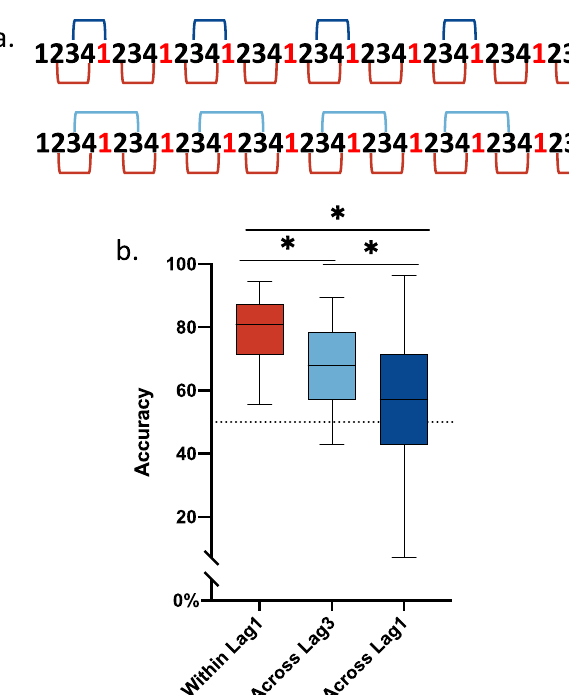
Fig. 2 Design and results of Experiment 2. a Schematic diagram of the task in Experiment 2. The sequence of 36 images was segmented as 4 items per event. Three pair types were tested for recency judgments, marked by red, light blue, and blue square brackets, representing within-event pairs with one intervening item (short for Within Lag1 in the fi gure), across-event pairs with three intervening items (short for Across Lag3 in the fi gure) and across-event pairs with one intervening item (short for Across Lag1 in the fi gure), respectively. b Box plots of group averaged temporal order memory for within and across-event pairs for lag1 and lag3 ( n = 27). A one-way repeated measures ANOVA on the accuracy of recency judgments showed a signi fi cant effect of Pair Type (F(1.448, 37.64) = 18.63, p < 0.001, η 2 = 25.47%). Simple effect analyses showed that TOM was signi fi cantly better for within-event pairs than across-event pairs (t(26) = 4.820, p < 0.001, two-sided, q < 0.05, FDR corrected for multiple comparisons), for within-event pairs at lag1 than for across-event pairs at lag3 (t(26) = 4.524, p < 0.001, two-sided, q < 0.05, FDR corrected), and for within-event pairs at lag1 than for across-event pairs at lag3 (t(26) = 4.524, p < 0.001, two- sided, q < 0.05, FDR corrected). Numbers in red denote event boundaries. The boxes show the inter-quartile range (IQR) and the median. Whiskers in box plots represent the minimum and maximum in the dataset. The asterisk (*) represents statistical signi fi cance at p < 0.05. Source data are provided as a Source Data fi